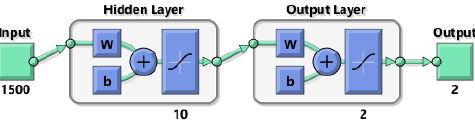
Figure 10. NET1_HF neural network diagram [39].